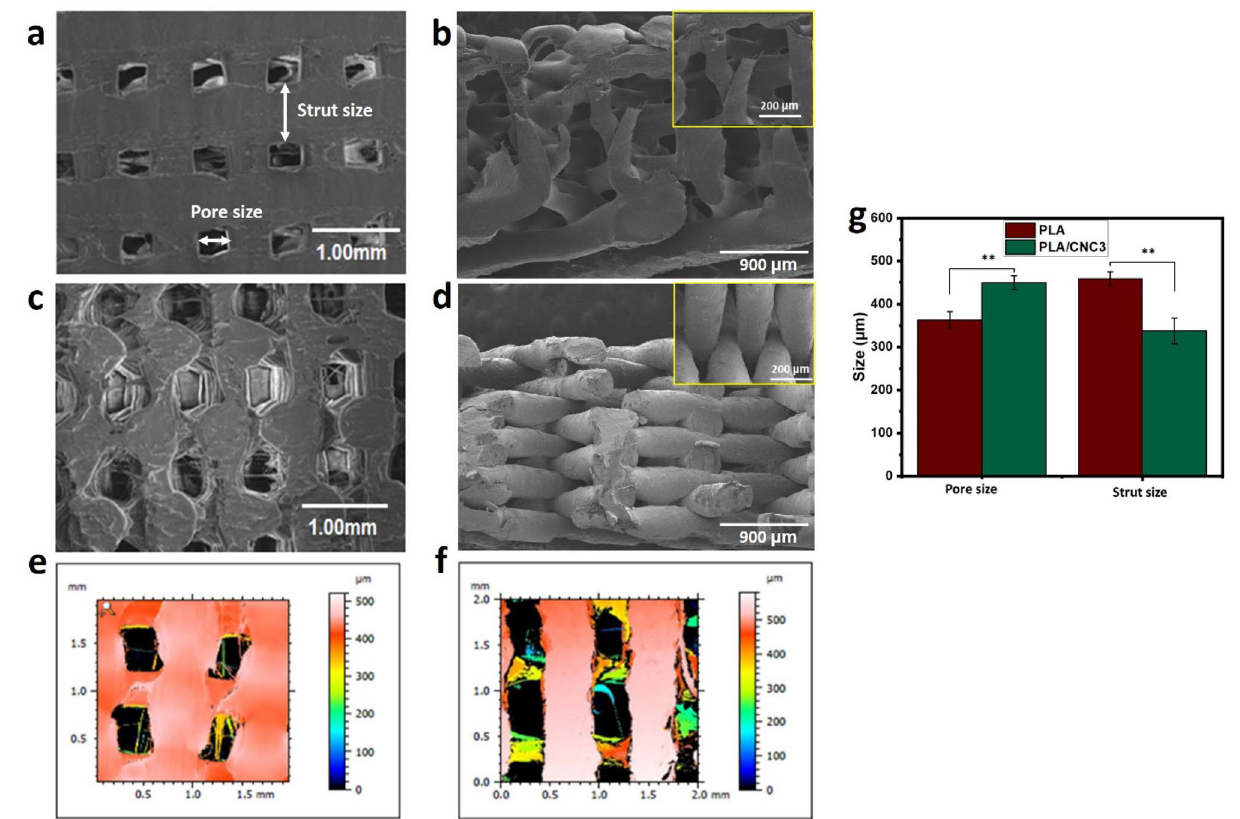
Figure 4. Scanning electron micrographs of 3D printed scaffolds: Top view of the morphology of ( a ) PLA and ( c ) PLA/CNC3. Cross-section with a zoom in inset of ( b ) PLA and ( d ) PLA/CNC3. ( g ) Statistical analysis of the 3D printed PLA and PLA/CNC diameters observed on top of the samples by SEM (Test Anova, ** p < 0.01). Topography of 3D printed scaffolds typically showing the surface roughness of ( e ) PLA and ( f )